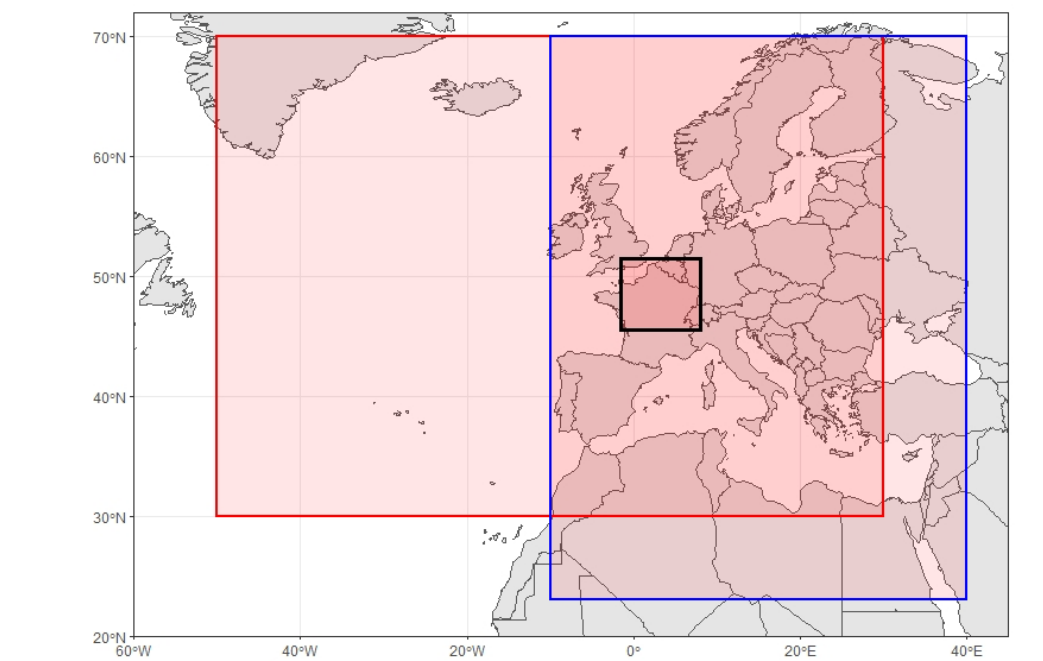
Figure 1. Regions used to identify circulation analogues for December temperatures (blue) and spring precipitation (red). The black rectangle indicates the region over which temperatures and precipitation are averaged in northern